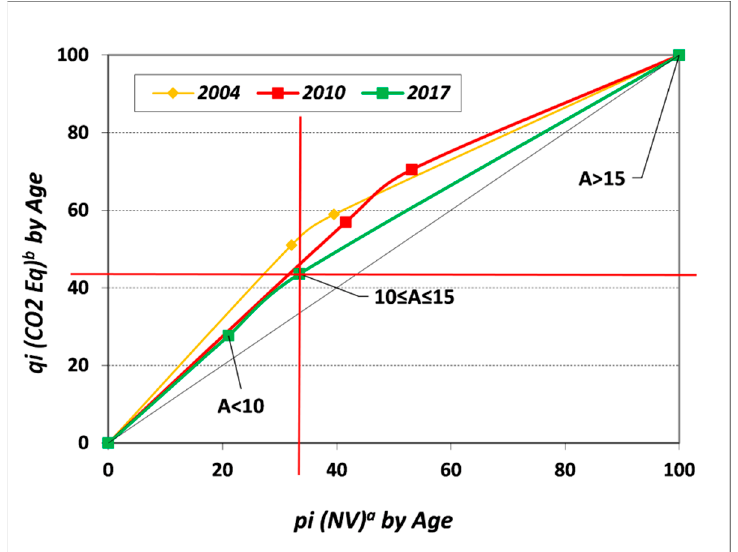
Figure 9. Lorenz curves of the greenhouse gas emissions of the Spanish tugboat fleet by age. Source: authors. a = accumulated percentage of tugboats by age; b = accumulated percentage of emissions of CO 2 equivalent by age.